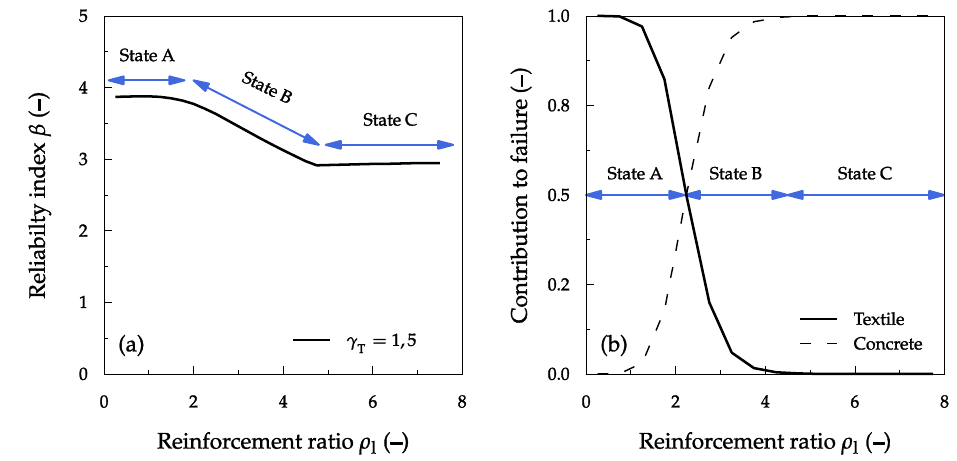
Figure 7. Results of the parametric studies: ( a ) reliability index; ( b ) contribution to failure.